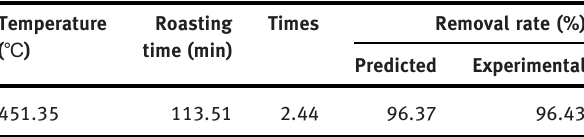
Table 7: Model validity of the response surface of dechlorination rate.